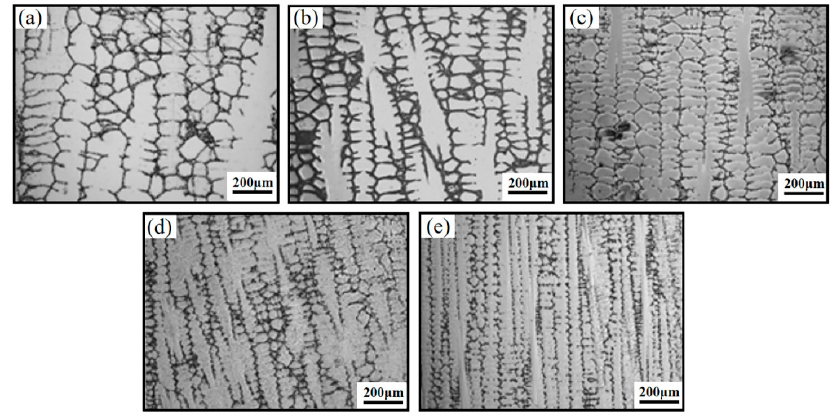
Figure 3. Microstructures of the stable growth zone of GH4720Li superalloys prepared at different withdrawal rates (mm/min): ( a ) 0.18; ( b ) 0.3; ( c ) 0.6; ( d ) 1.2; ( e ) 2.4.